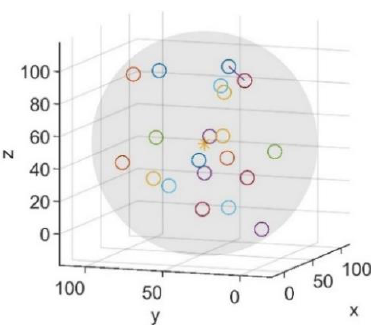
Figure 3. Schematic diagram of the inner boundary of the cluster.